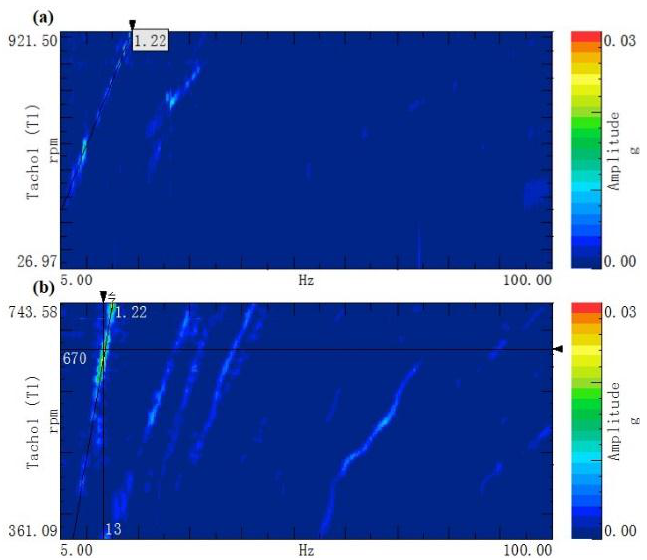
Figure 10. The order tracking colormap of the acceleration in y- direction: ( a ) improved cab mount and ( b ) original cab mount.